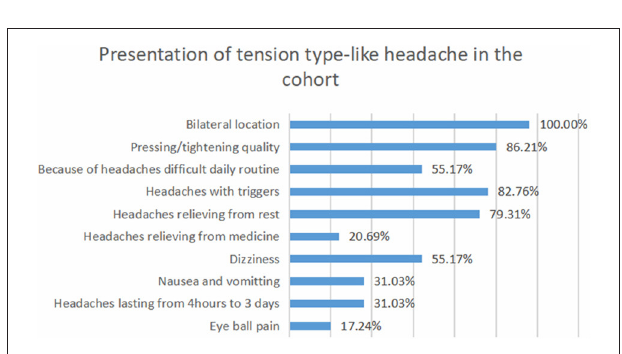
FIGURE 2 | Presentation of tension-type-like headache in the